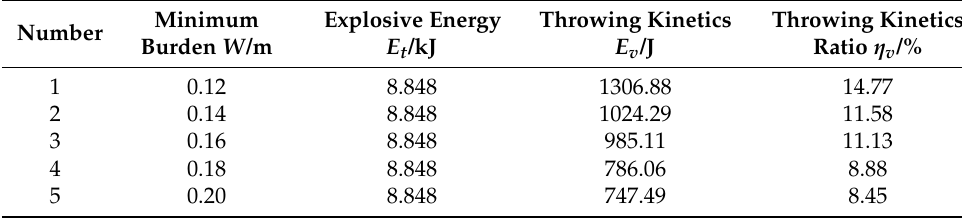
Table 6. Model throwing kinetic energy.